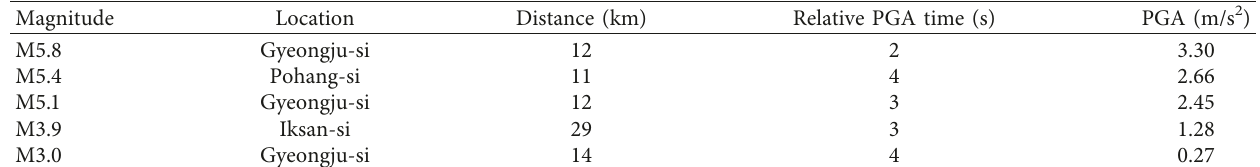
Table 3: Earthquake information for the five earthquakes used in the time-history